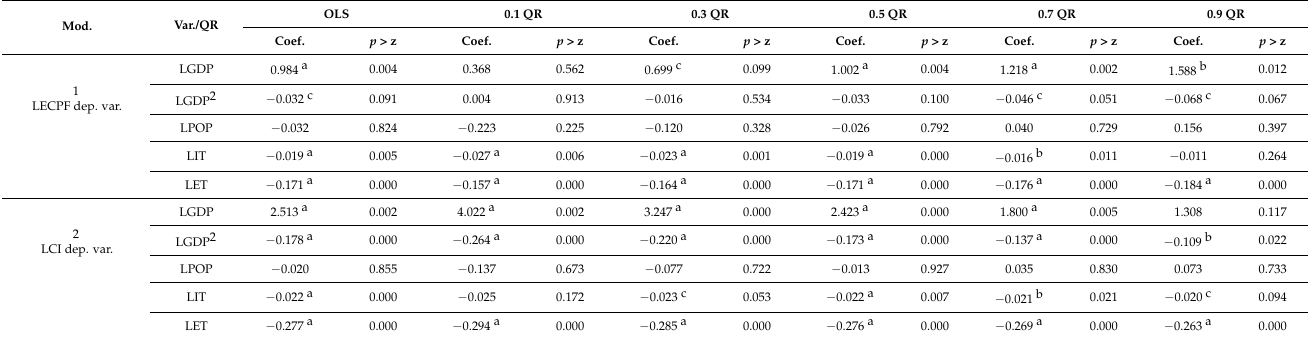
Table 7. OLS-DK and MMQR